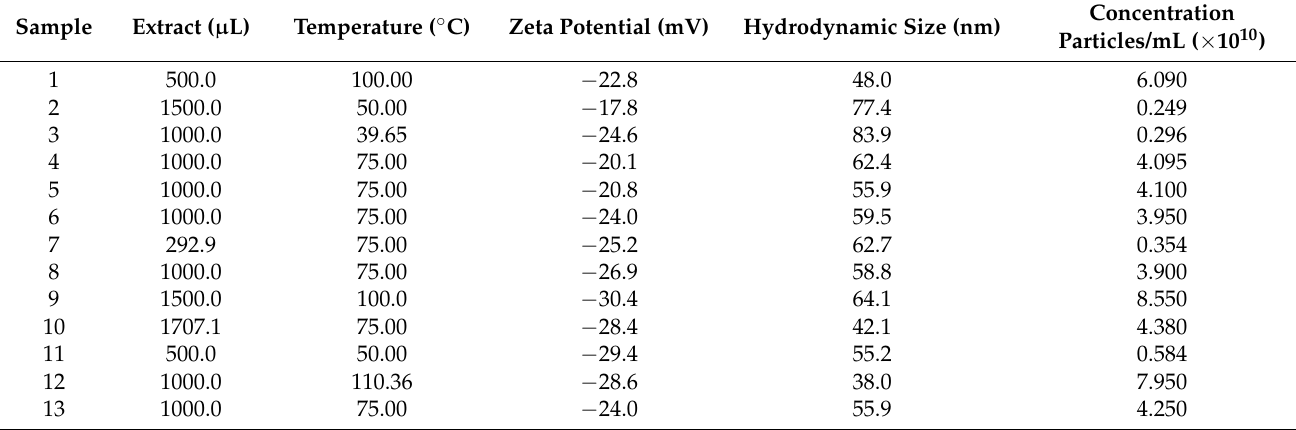
Table 2. Central composite design-based experimental runs and response variables for the synthesis of Ag@Se NPs. Sample Extract ( µ L) Temperature ( ◦ C) Zeta Potential (mV) Hydrodynamic Size (nm)